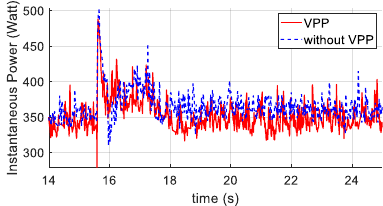
Figure 13. Instantaneous power during the first flight test scenario.